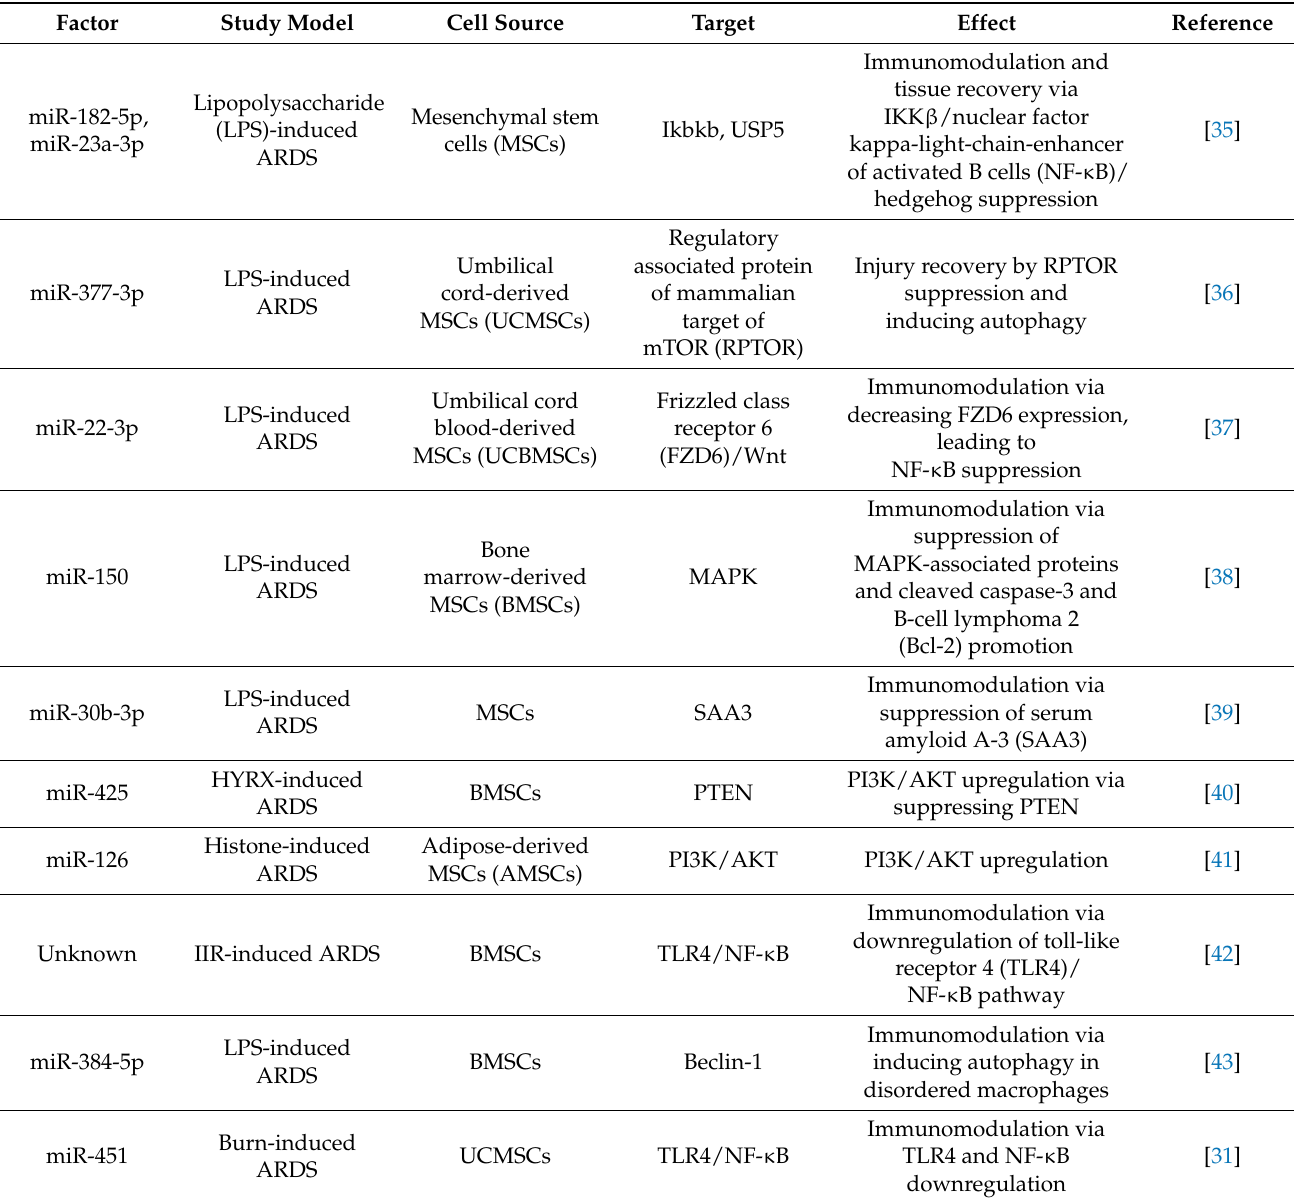
Table 1. Effects of stem cell-derived exosomes (SC-Exos) on acute respiratory distress syndrome (ARDS)